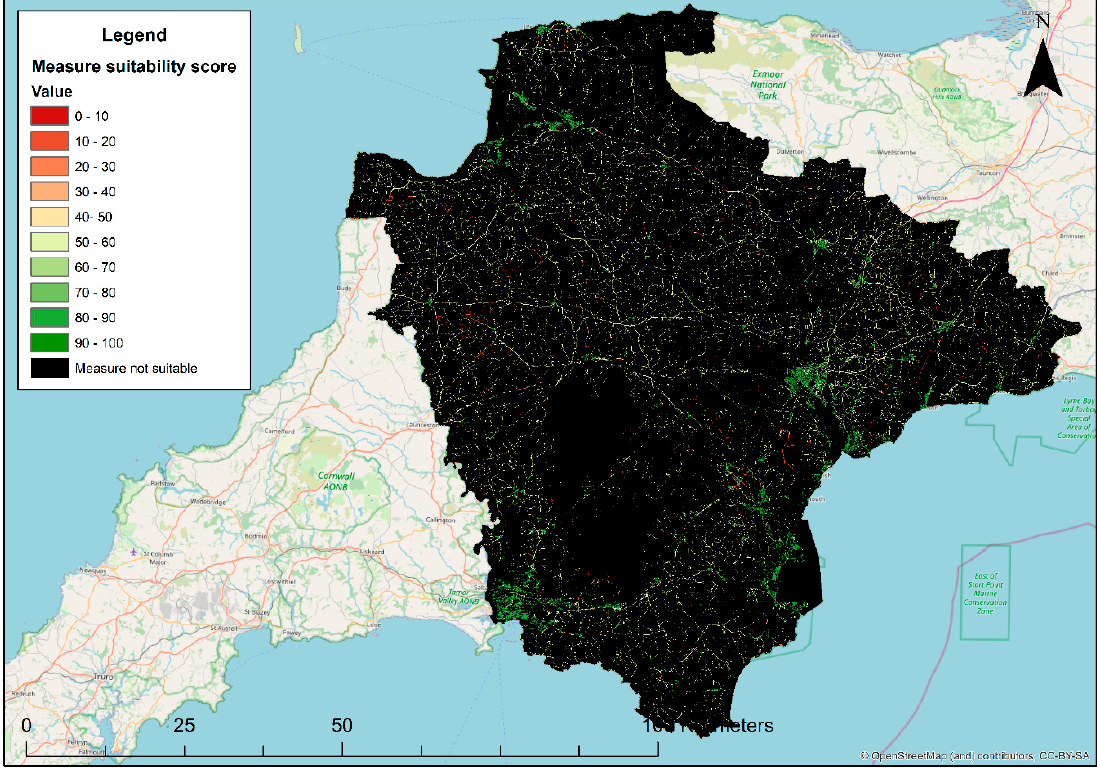
Figure 5. Needs map showing requirement for the benefits of swales in Devon.